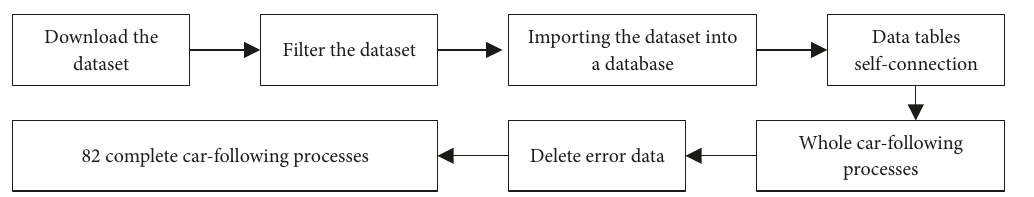
Figure 2: Data processing